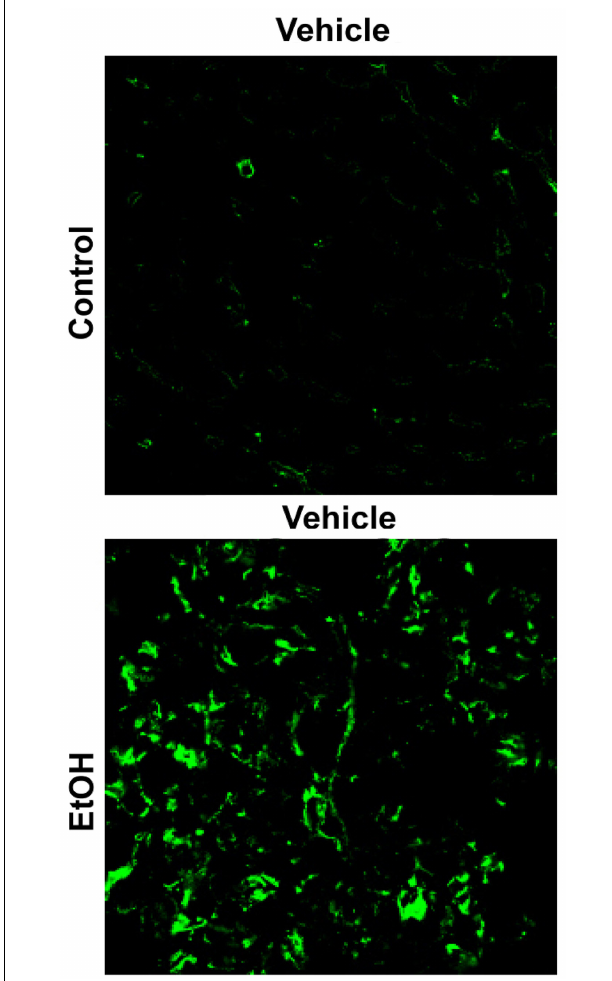
FIGURE 2 | Chronic ethanol increases hepatic fibrin(ogen) deposition. Representative photomicrographs (40 × ) depicting immunofluorescent detection of fibrin(ogen) ECM are shown. Liver tissue is from mice fed either control diet or enteral ethanol diet for